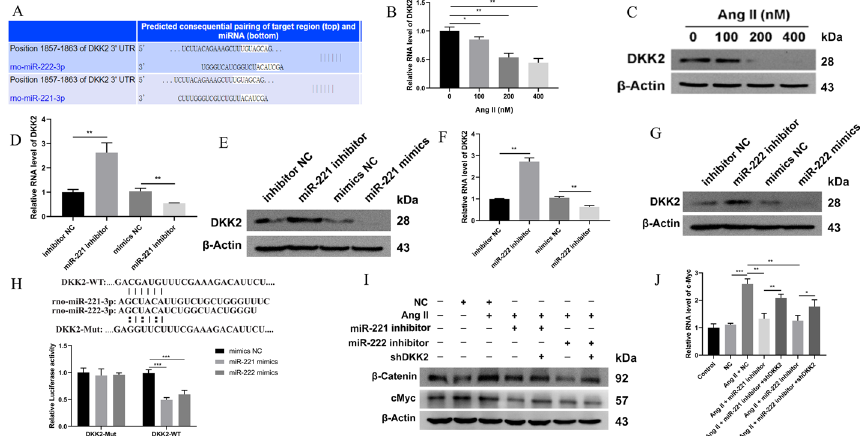
3. C Western blot detected the expression of DKK2 in NRCMs = stimulated with Ang-II. n 3. D qRT-PCR detected the expression of DKK2 in NRCMs transduced with miR-221 = mimics and inhibitors. n 3. E Western blot detected the expression of DKK2 in NRCMs transduced with = miR-221 mimics and inhibitors. n 3. F qRT-PCR detected the expression of DKK2 in NRCMs transduced with = miR-222 mimics and inhibitors. n 3. G Western blot detected the expression of DKK2 in NRCMs transduced = with miR-222 mimics and inhibitors. n 3. H Predictive miR-221/222 binding sites in the 3 ′ -UTR of DKK2 = mRNA. Dual-luciferase reporter assays demonstrated that DKK2 was a direct target of miR-221/222. I Western